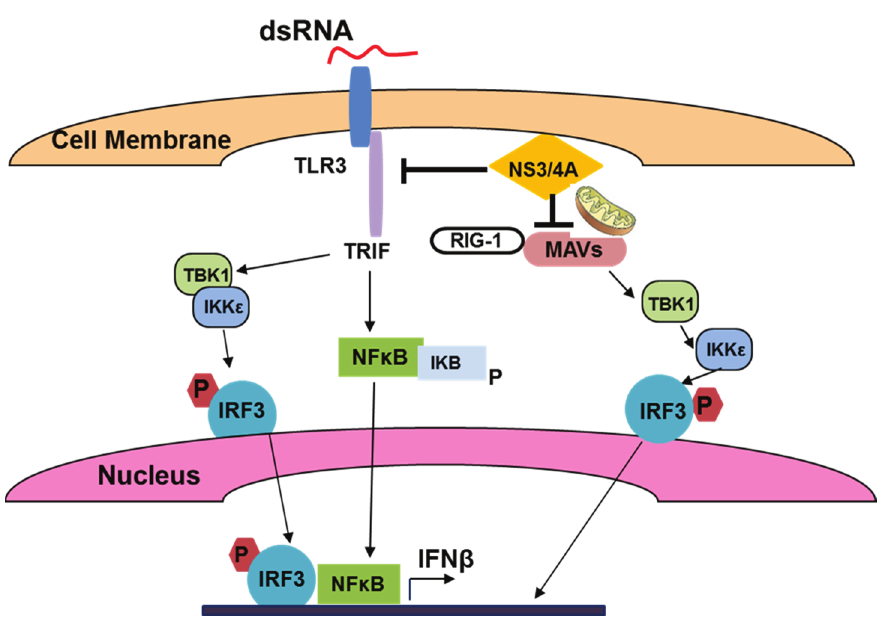
Figure 2. Sensing of viral (HCV) dsRNA by TLR3 and activation of IFN(cid:2)